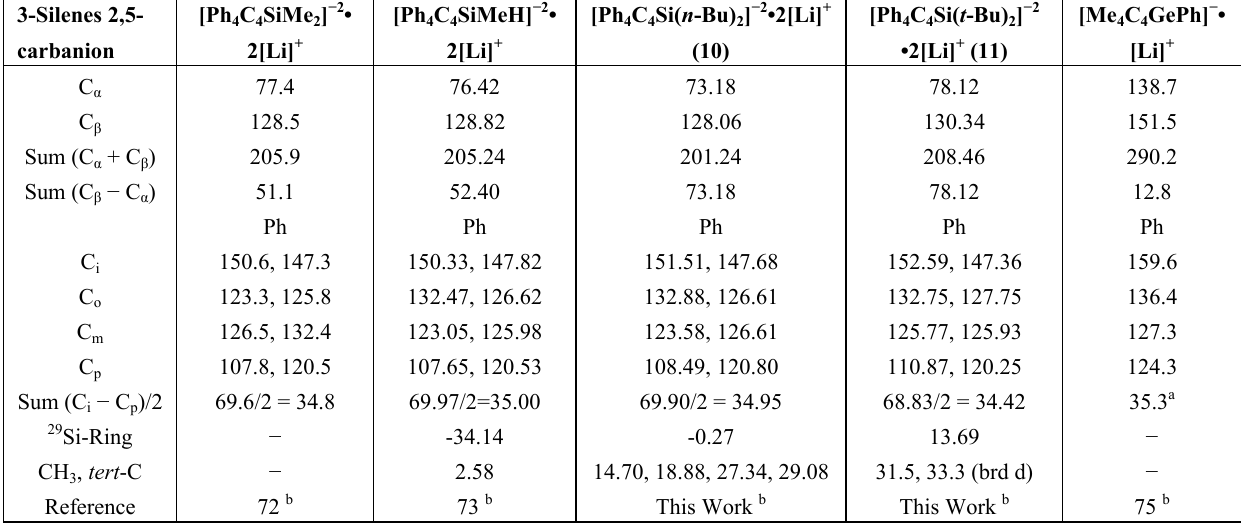
Table 1. 13 C/ 29 Si-NMR chemical shifts of the localized 3-silolenides and germole anions.